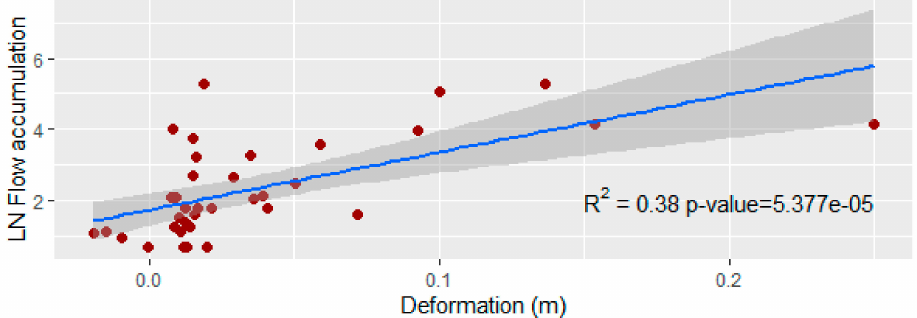
Figure 10. Scatter plot of the wall deformation (D f or D b ) vs. logarithmic flow accumulation values.